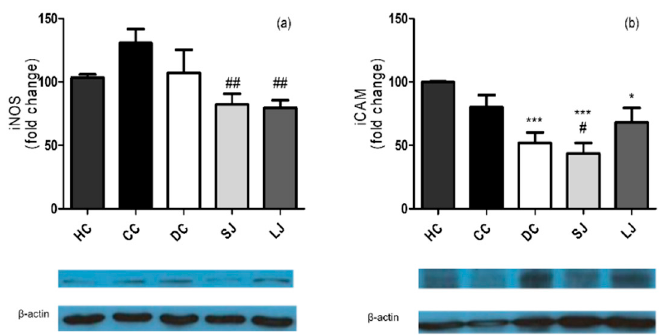
Figure 5. Western blotting inflammation markers in the colon. ( a ) Inducible nitric oxide synthase (iNOS) and ( b ) Intercellular adhesion molecule 1 (ICAM-1) (fold change). HC = healthy control; CC = colitis control; DC = drug (mesalazine) control; SJ = short-term EJP extract treatment; and LJ = long-term EJP extract treatment. Results are expressed as the mean ± error standard ( n = 3–5). * Indicates significant di ff erence from HC group and # from CC group by one-way ANOVA and Tukey’s test (1 code = p < 0.05; 2 codes = p < 0.01; and 3 codes = p <